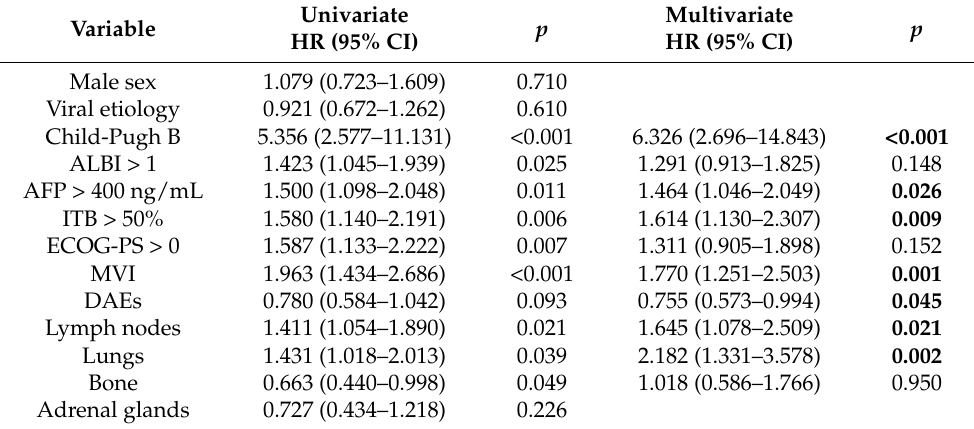
Table 4. Univariate and multivariate Cox regression analysis of overall survival in the cohort of patients with a single site of metastases.